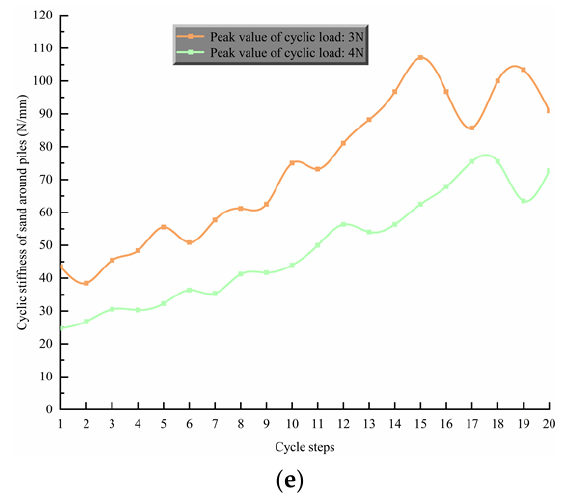
Figure 8. Curve of cyclic stiffness of sand around piles—cycle steps. ( a ) Group 1 and Group 6, ( b ) Group 2 and Group 7, ( c ) Group 3 and Group 8, ( d ) Group 4 and Group 9, ( e ) Group 5 and Group 10